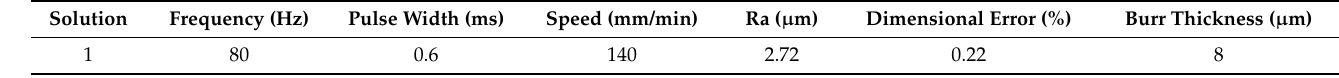
Figure 8. Contour plot of burr thickness error vs. frequency and speed. Table 4. Results of the multiobjective